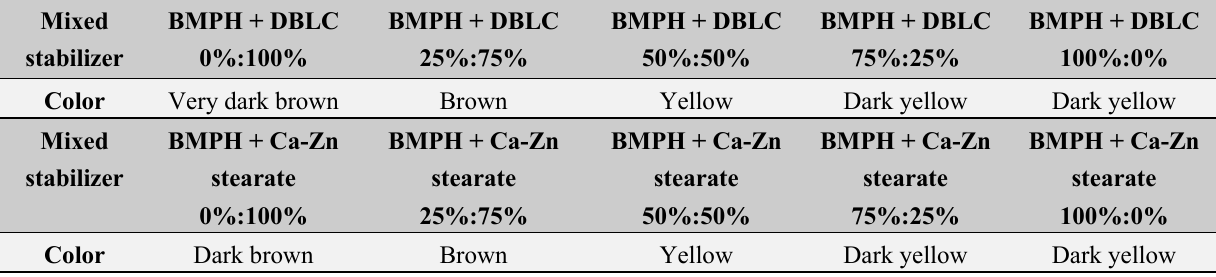
Table 5. Extent of discoloration of rigid PVC thermally degraded at 180 °C in air, for 60 min, in the presence of different weight ratios of stabilizers.